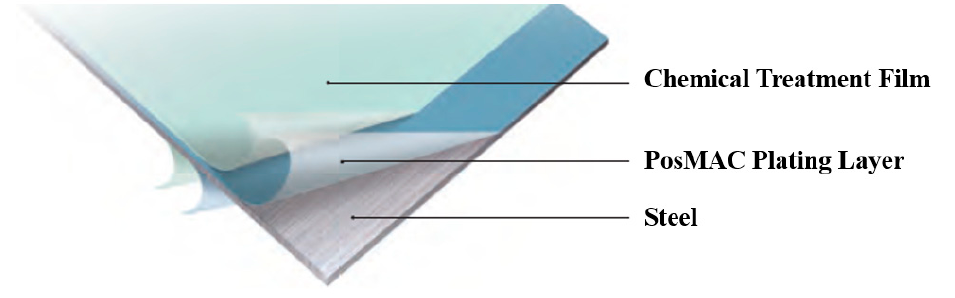
Figure 5. Composition of alloy plated steel sheet.